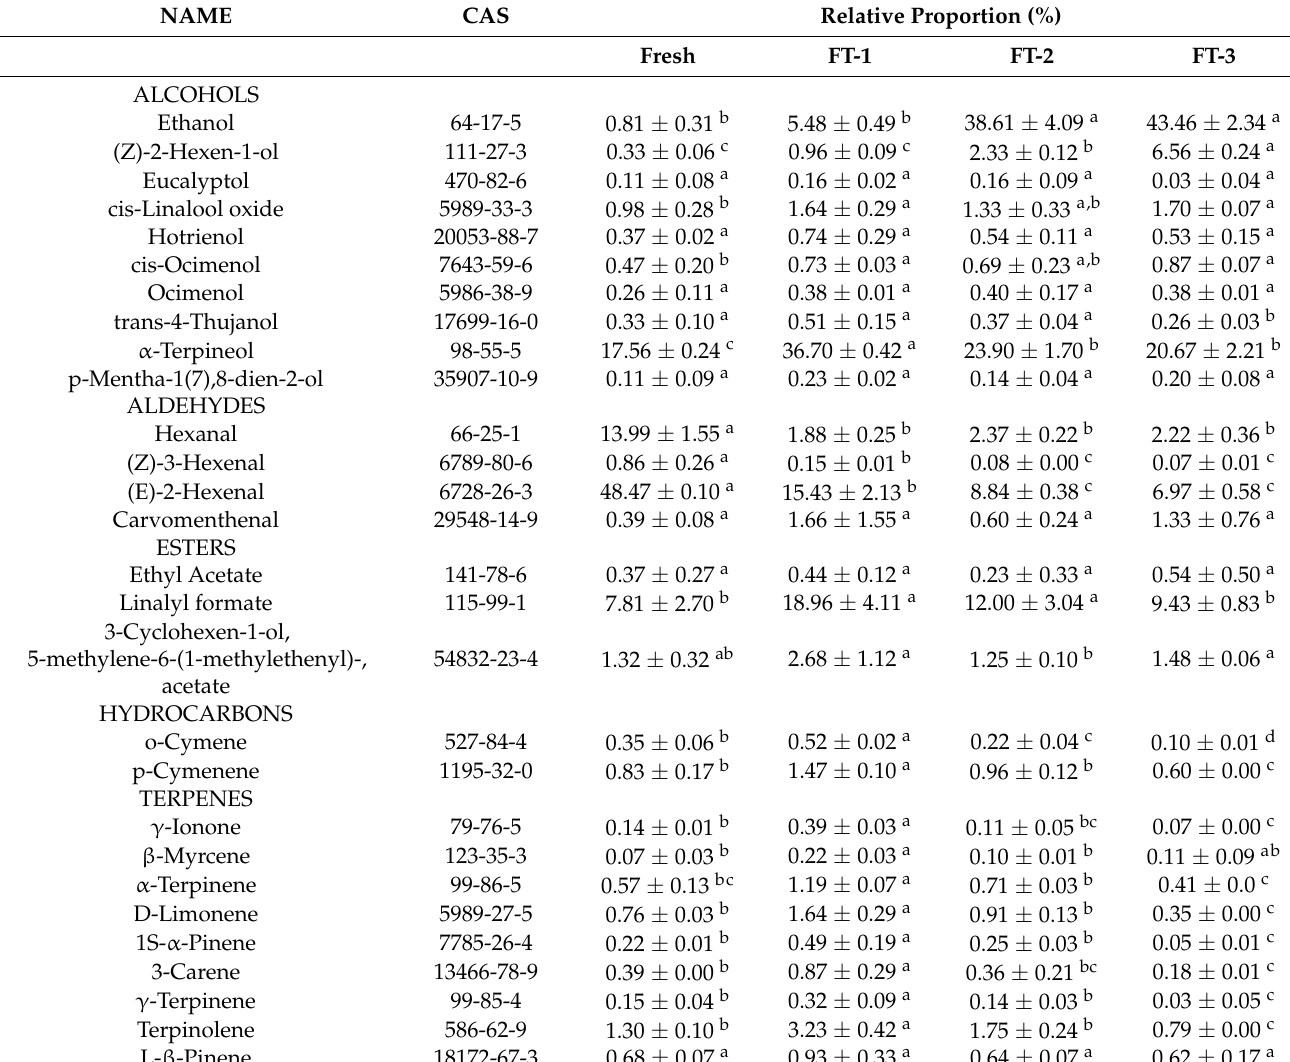
Table 2. Volatile organic compounds found in different freeze-thaw (FT) treated samples and its relative proportion (%) based on total ion chromatogram (TIC) peak areas in headspace gas chromatography-mass spectrometry. FT-1, FT-2 and FT-3 represent the sample with FT treatment once, twice and third